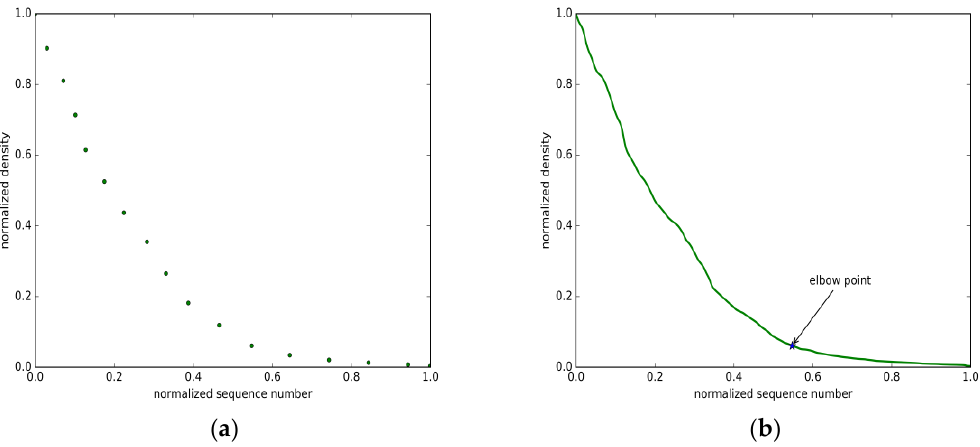
Figure 5. Sampled density sequence and ‘elbow point’. ( a ) Density sequence after sample and ( b ) the final ‘elbow point’.